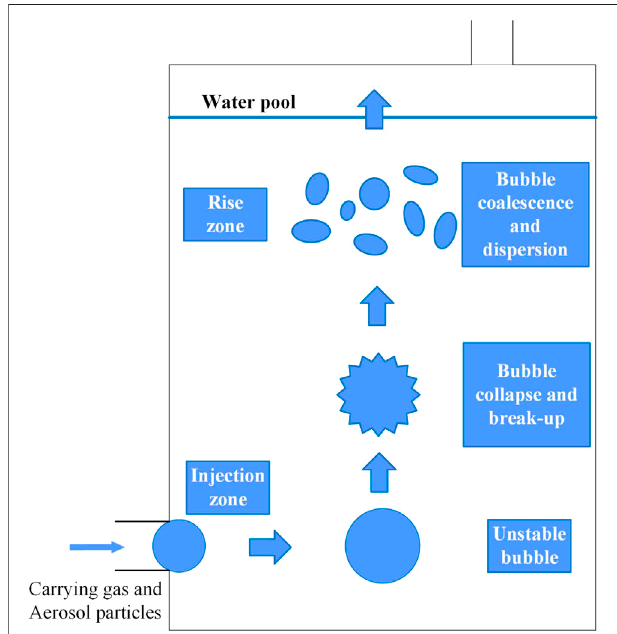
FIGURE 1 | Schematic diagram of pool scrubbing